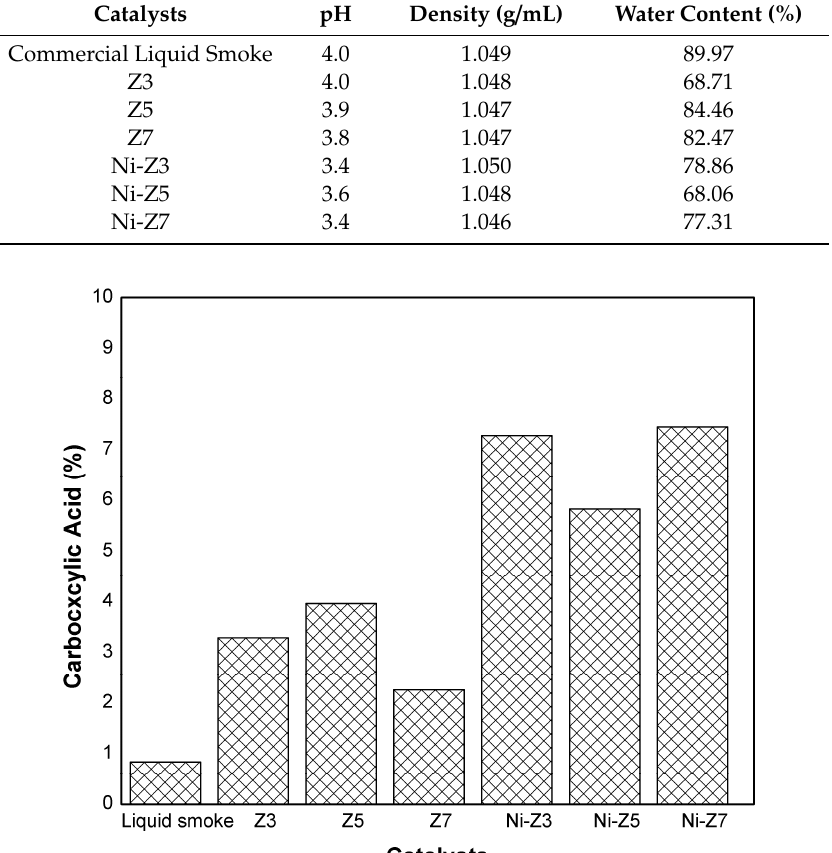
Table 9. Main components in commercial and HDO liquid smoke.